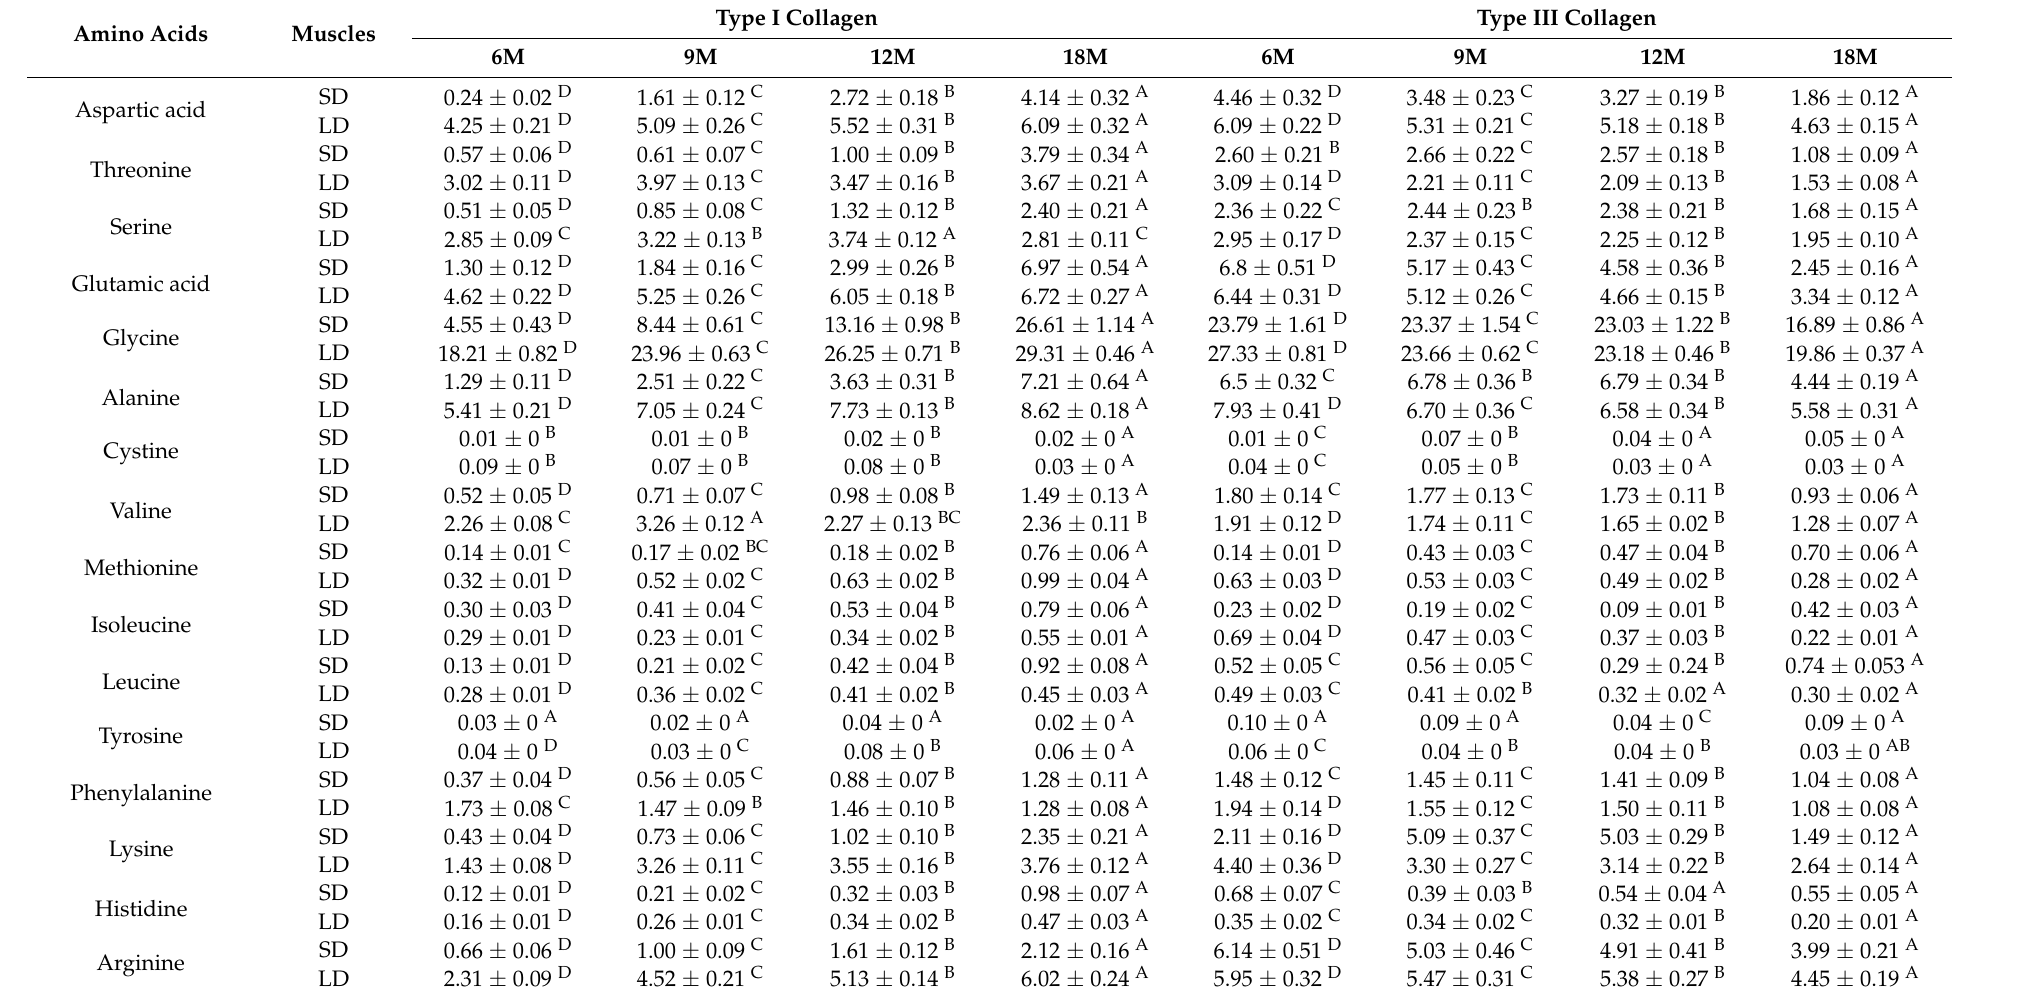
Table 1. Amino acid composition of type I and III collagen from Semitendinosus (SD) and Longissimus dorsi (LD) in different growth